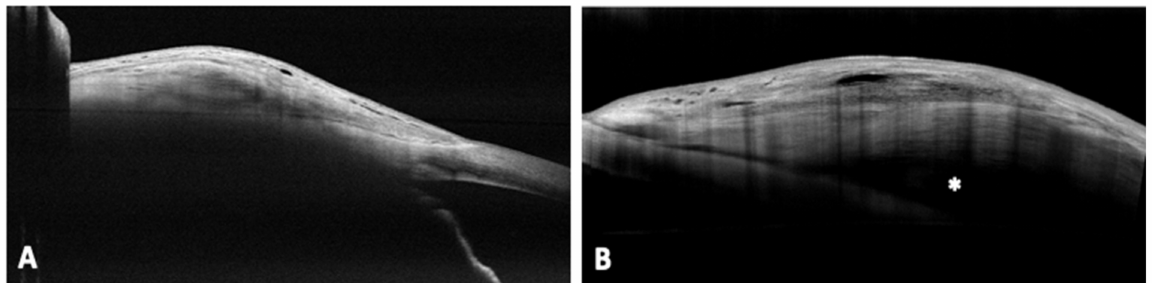
Figure 3. AS-OCT image of a uniform bleb after 6 month from XEN implantation ( A ), and uniform morphology of a PreserFlo bleb with an associated PEF lake, indicated by the white asterisk, after 6 months ( B ). AS-OCT = anterior segment-optical cohernce tomography; PEF = posterior episcleral